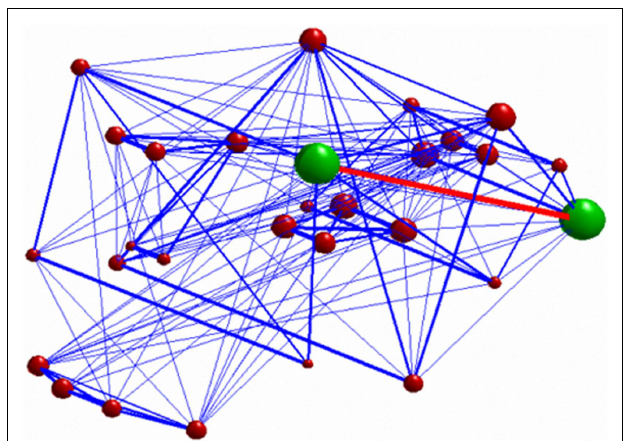
FIGURE 4 | 3D graph representing the investigated network .The green nodes indicate the ROIs whose connectivity (represented by the red edge) was decreased after stimulation.The radius of each of the red nodes reflects the node strength (i.e., the sum of the weights of each edge connected to the node).The thickness of the edges reflect the strength of correlation between each node. Only connections with correlation coefficient > 0.3 are